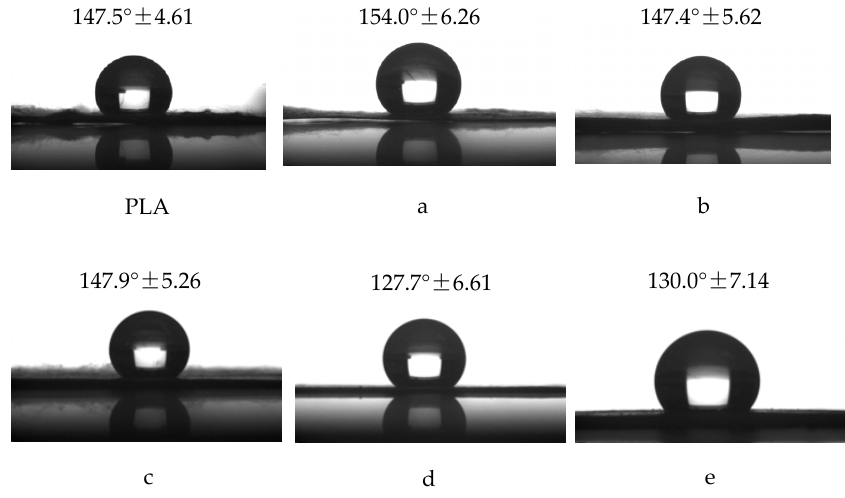
Figure 6. Static contact angle of PLA fibers, porous core-shell fibers with the weight ratio 9:1 at core solution flow rates of ( a ) 0.05 mL/h; ( b ) 0.1 mL/h; and ( c ) 0.2 mL/h, respectively, and nonporous core-shell fibers at core solution flow rates of 0.2 mL/h with the weight ratio (DCM/DMF) ( d ) 7:3 and ( e ) 5:5.